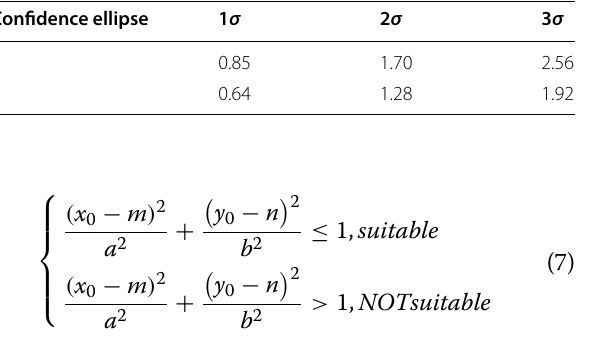
Table 1 Lengths of the semi-major axis ( a ) and semi-minor axis ( b ) of the three confidence ellipses with different confidence